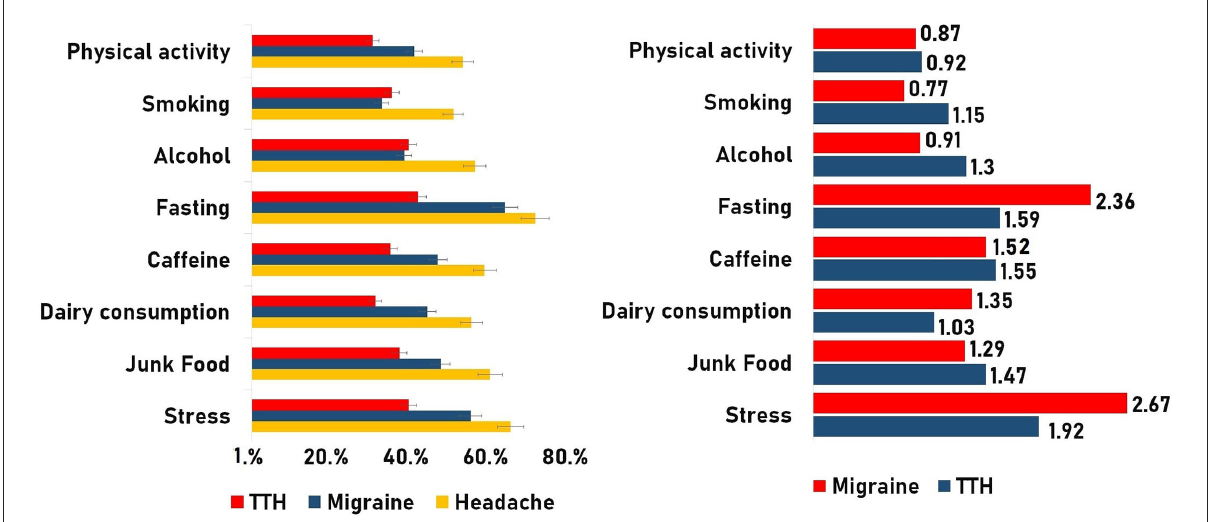
FIGURE6 Two-dimensional (2D) bar graph representing. (Left) Prevalence of diseases under different exposures, (Right) Prevalence ratio in migraine and tension-type headaches (TTH).